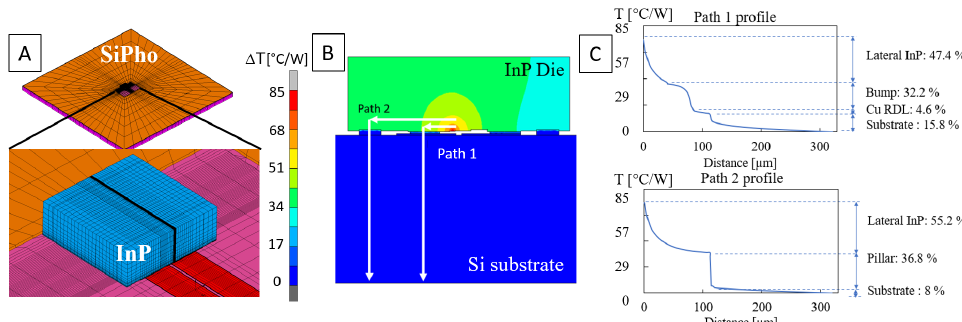
Figure 12. ( A ) Finite element model of SiPho die with the detail of the InP laser laser; ( B ) laser cross- section showing temperature contours; ( C ) temperature profiles through solder bump and